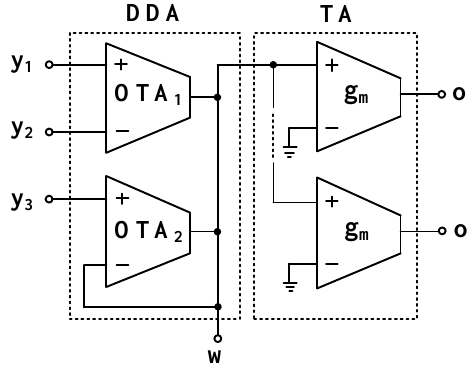
Figure 16. OTA-based DDTA [52].